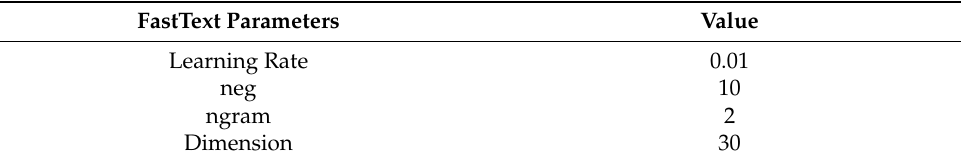
Table 3. Super parameters of ERNIE and BERT model training.